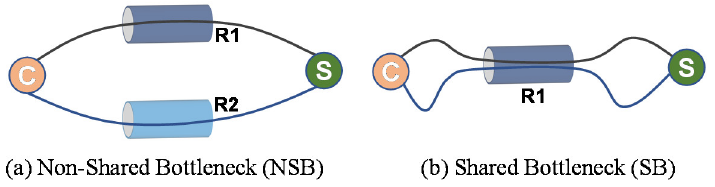
Figure 1. Conceptual representation of—( a ) non-shared bottleneck (NSB), ( b ) shared bottleneck (SB). The congestion control algorithm (CCA) used with the MPTCP plays a vital role